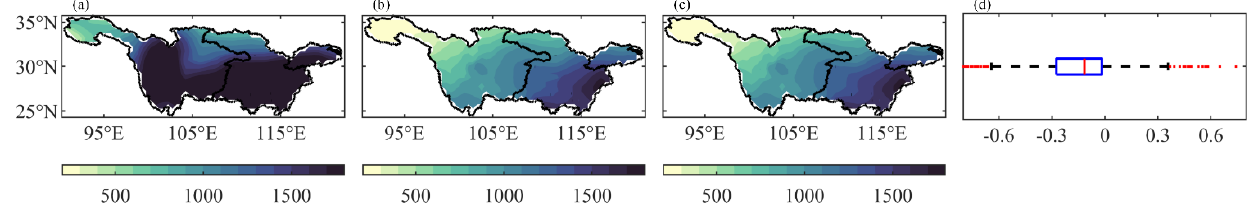
Figure 2. Mean annual precipitation (mm/a) in the Yangtze River basin from 1981 to 2010: ( a ) ACCESS-CM2, ( b ) corrected ACCESS-CM2, ( c ) observation, ( d ) the absolute value of the difference between the corrected model and observed annual mean precipitation (mm).